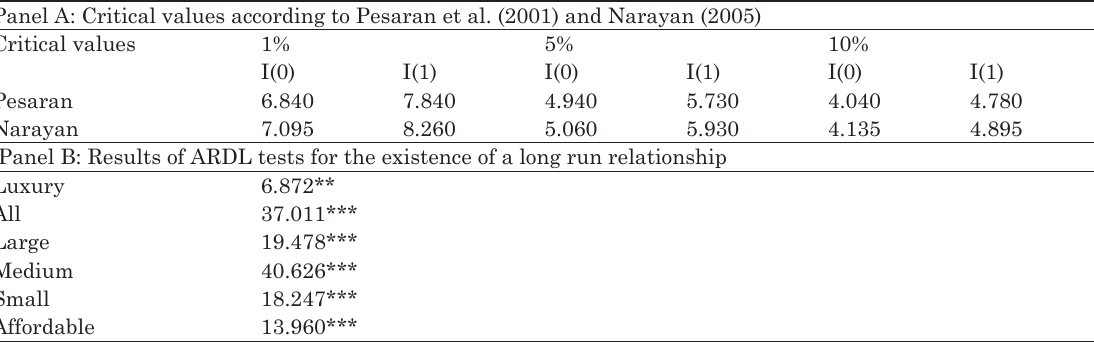
Table 1. Autoregressive distributed lag (ARDL) model analysis 7 Panel A: Critical values according to Pesaran et al. (2001) and Narayan (2005) Critical values